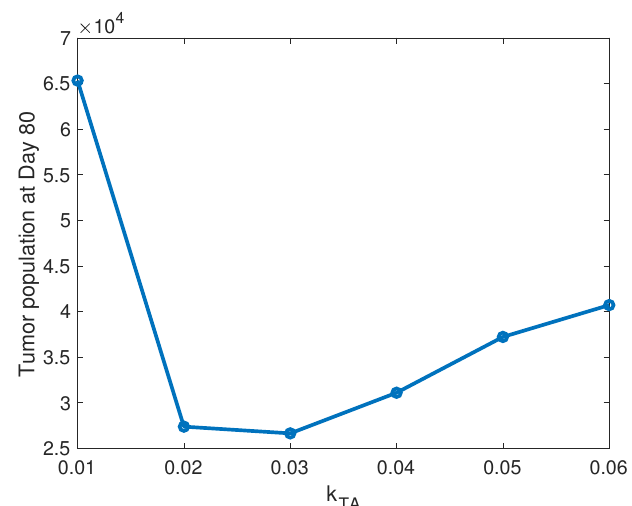
Figure 3. Antitumor T cell killing rate. This figure depicts the mean tumor population at Day 80, as a function the tumor cell killing rate by antitumor T cells, k TA . Means are calculated from 10 simulations performed for k TA = [ 0.01,0.02,0.03,0.04,0.05,0.06 ] , with all other parameters set at their baseline levels, including a AT =